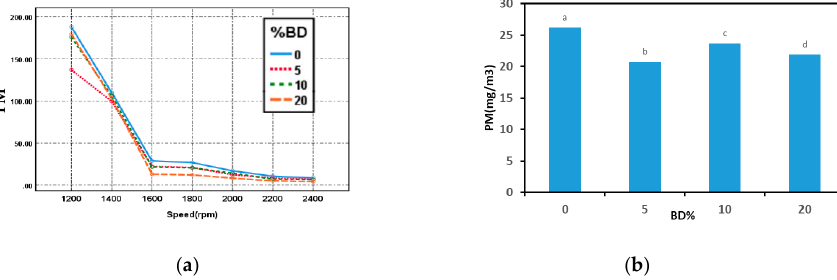
Figure 11. ( a ) Particulate matter (PM) vs. S at 100% load; ( b ) mean values of total data of PM for different speeds and loads. The letters a-d inside the diagram indicate significant differences ( P ≤ 0.05).